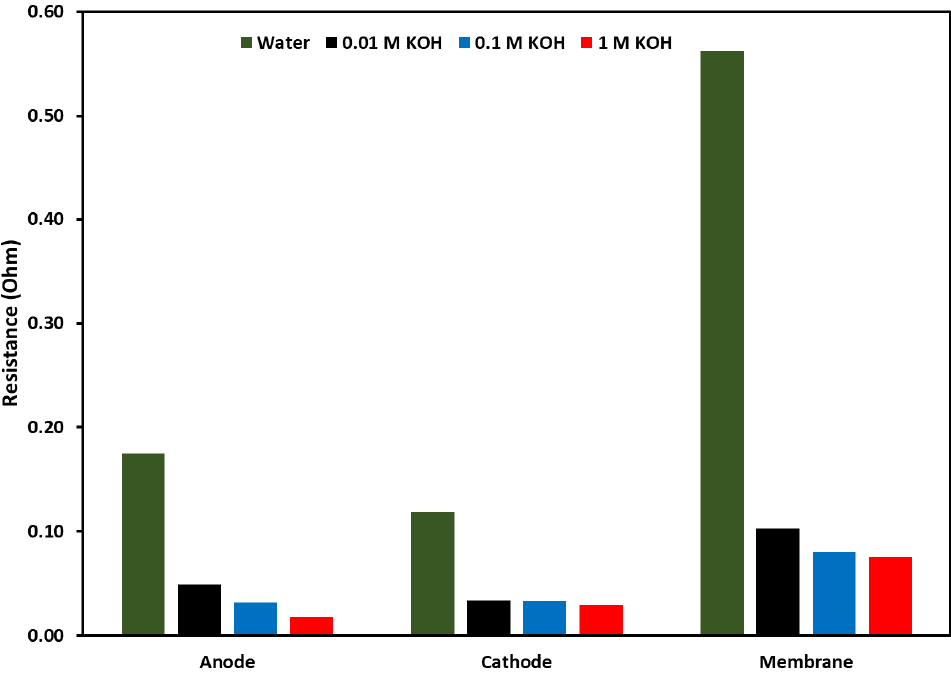
Figure 12. Comparison of resistances at anode, cathode, and membrane, the resistances were evalu- ated by using equivalent circuit fitting. The applied voltage was 2 V at 70 °C.